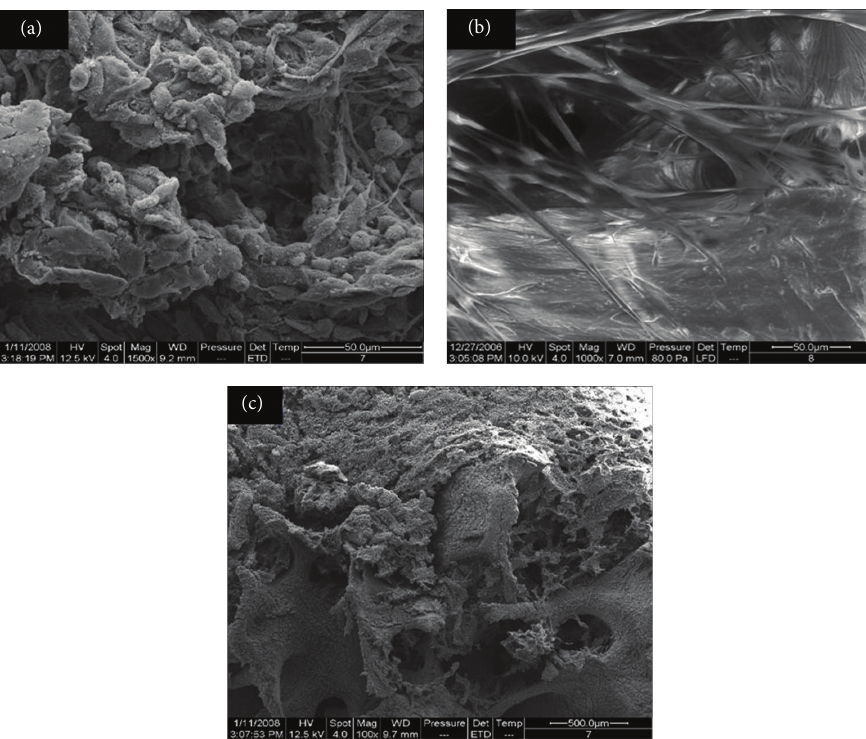
Figure 4: SEM of cell attachment on scaffolds: cell adhesion of (a) cartilage layer ( × 1500), (b) bone layer ( × 1000), and (c) both layers ( × 100).